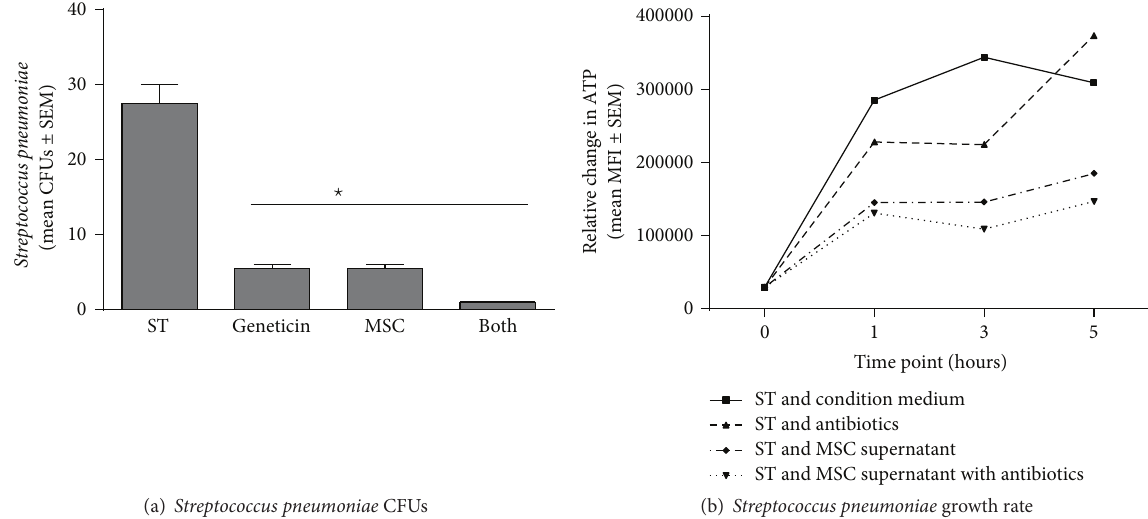
Figure 4: hMSCs and their products on Streptococcus pneumoniae growth. Bone marrow derived hMSCs supernatants were cultured with different dosages of Streptococcus pneumoniae with and without the addition of geneticin (100 𝜇 g/mL). Aliquots of the bacteria were streaked onto MacConkey plates for CFUs (a) or evaluated for ATP production (b). hMSC supernatants ( 𝑛 = 8 different donors) significantly decreased both Streptococcus pneumoniae CFUs ((a), 𝑃 ≤ 0.05 ) and growth rates ((b), 𝑃 ≤ 0.05 ). Geneticin was used as a positive control, decreasing both CFUs ( 𝑃 ≤ 0.05 ) and growth rates ( 𝑃 ≤ 0.05 ). hMSC supernatants decreased CFUs and enhanced antibiotic sensitivity when measuring CFUs. However, hMSCs supernatants had minimal antibiotic enhancing effect on Streptococcus pneumonia growth rate (b). ST = Streptococcus pneumoniae growth without treatment. Geneticin = treatment with the antibiotic geneticin, +hMSCs = treatment with hMSC derived supernatant, and Both = treatment with both MSC supernatants and